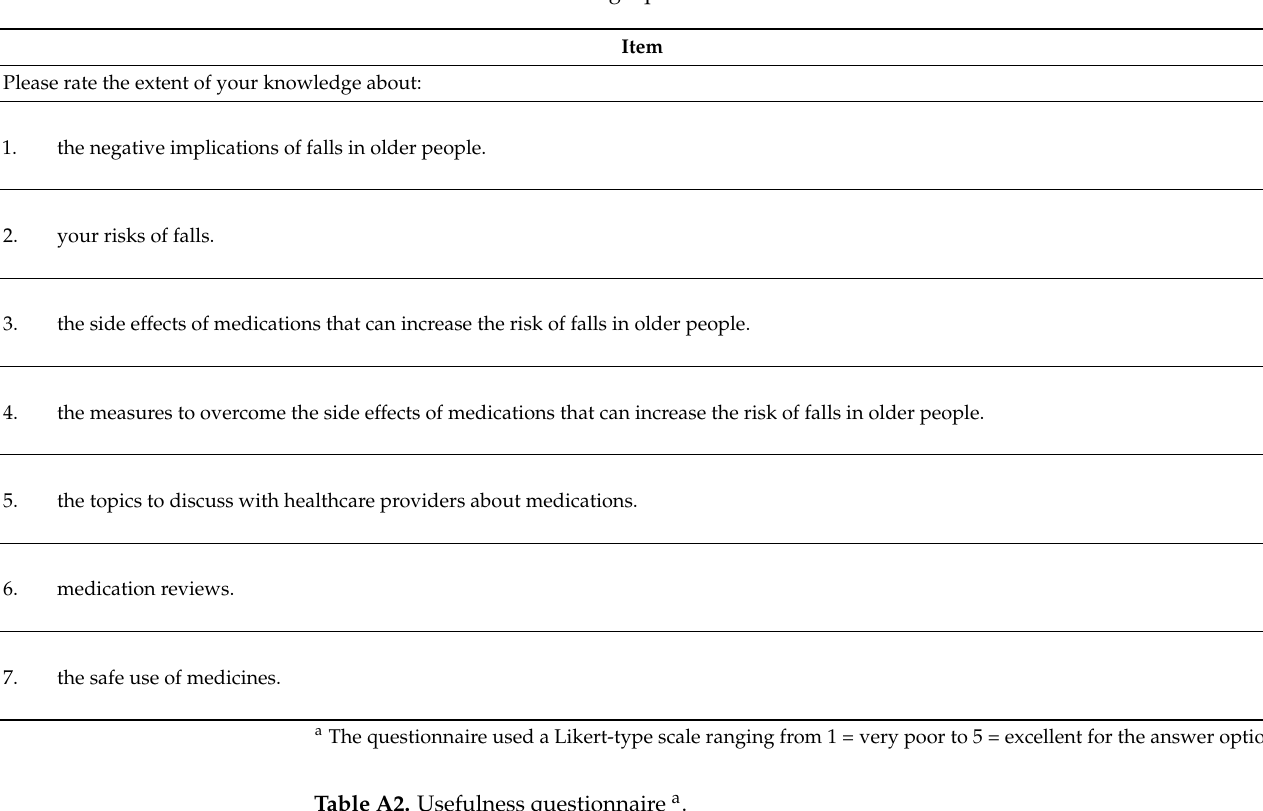
Table A2. Usefulness questionnaire a